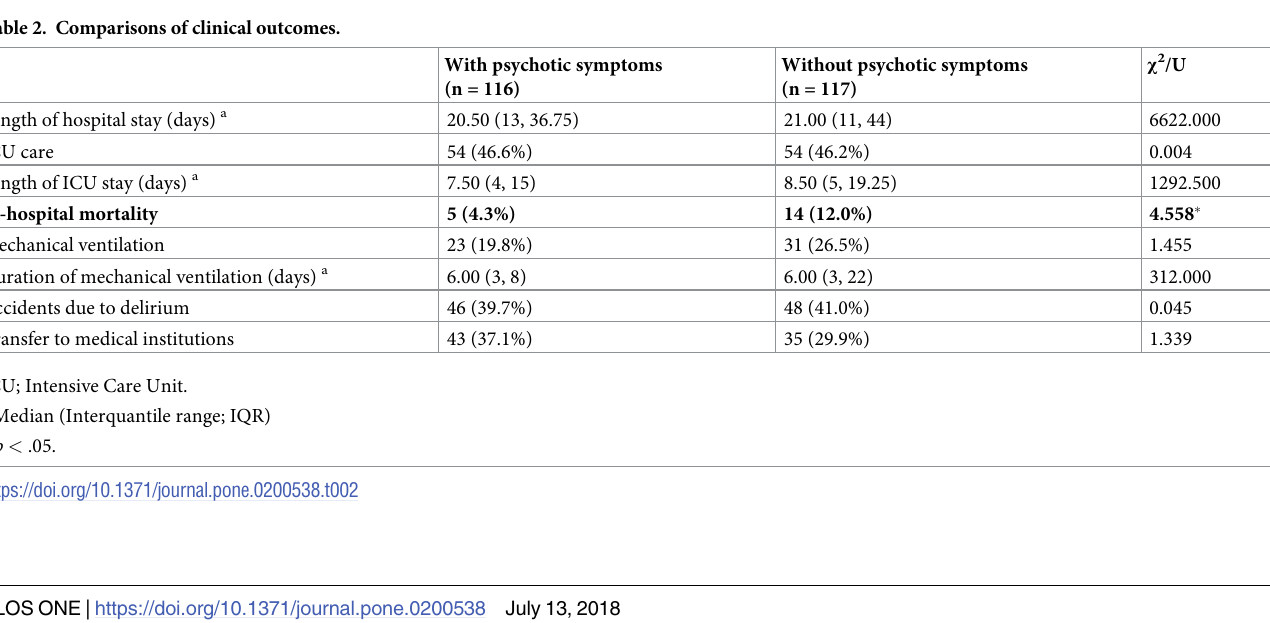
Table 2 showed differences in clinical outcomes between groups. Delirium with psychotic